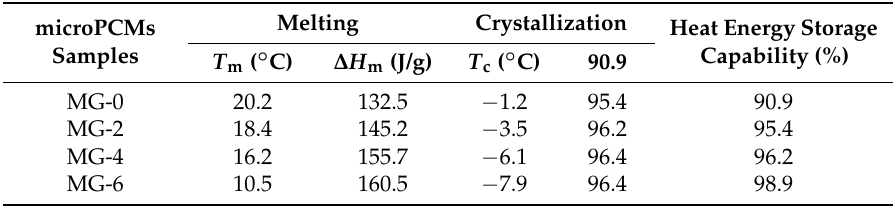
Table 2. The phase change data of microPCMs samples calculated through differential scanning calorimetry (DSC)